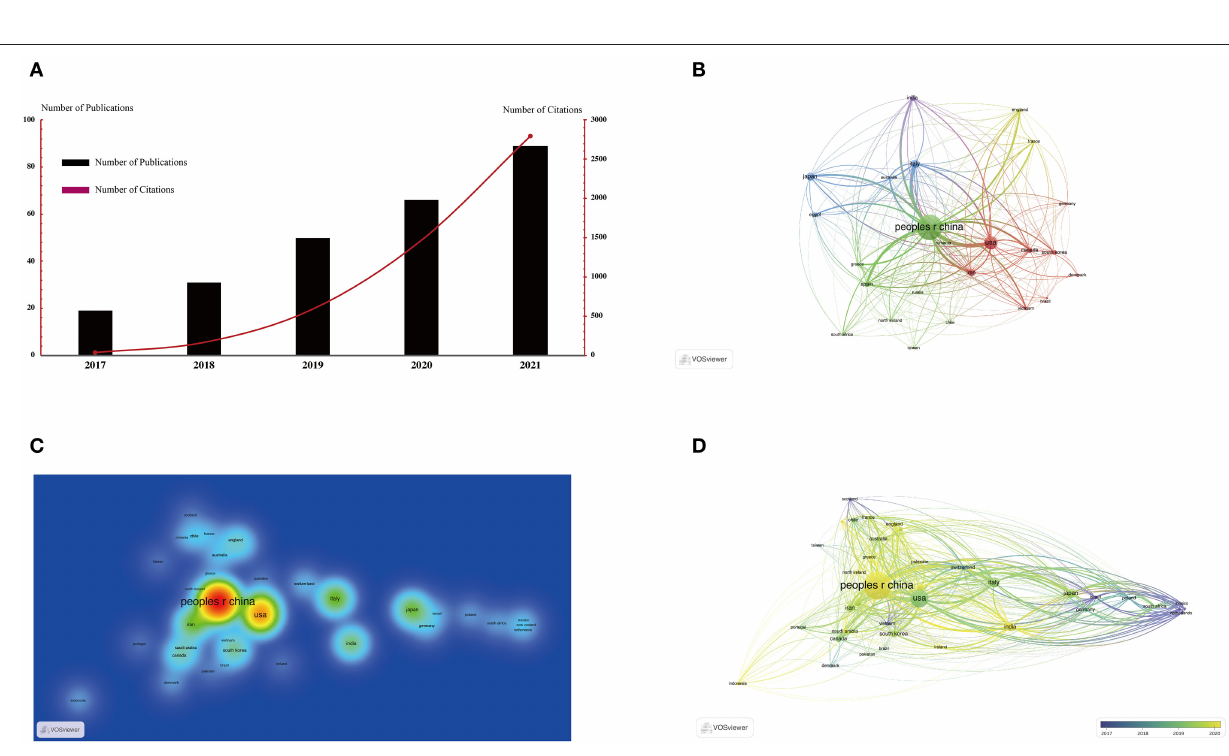
Frontiers in Public Health | www.frontiersin.org 3 June 2022 | Volume 10 | Article